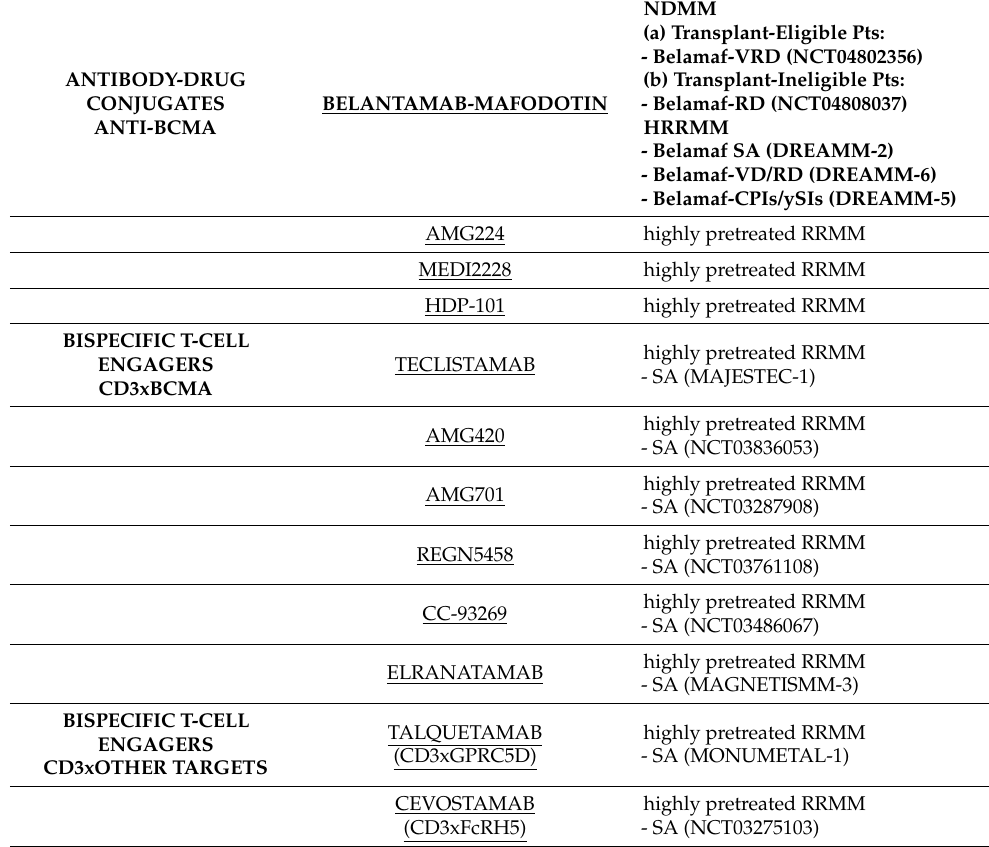
Table 2. Overview of “new” moAbs with targets and clinical indications. NDMM: newly diag- nosed multiple myeloma; RRMM: relapsed-refractory multiple myeloma; pts: patients;